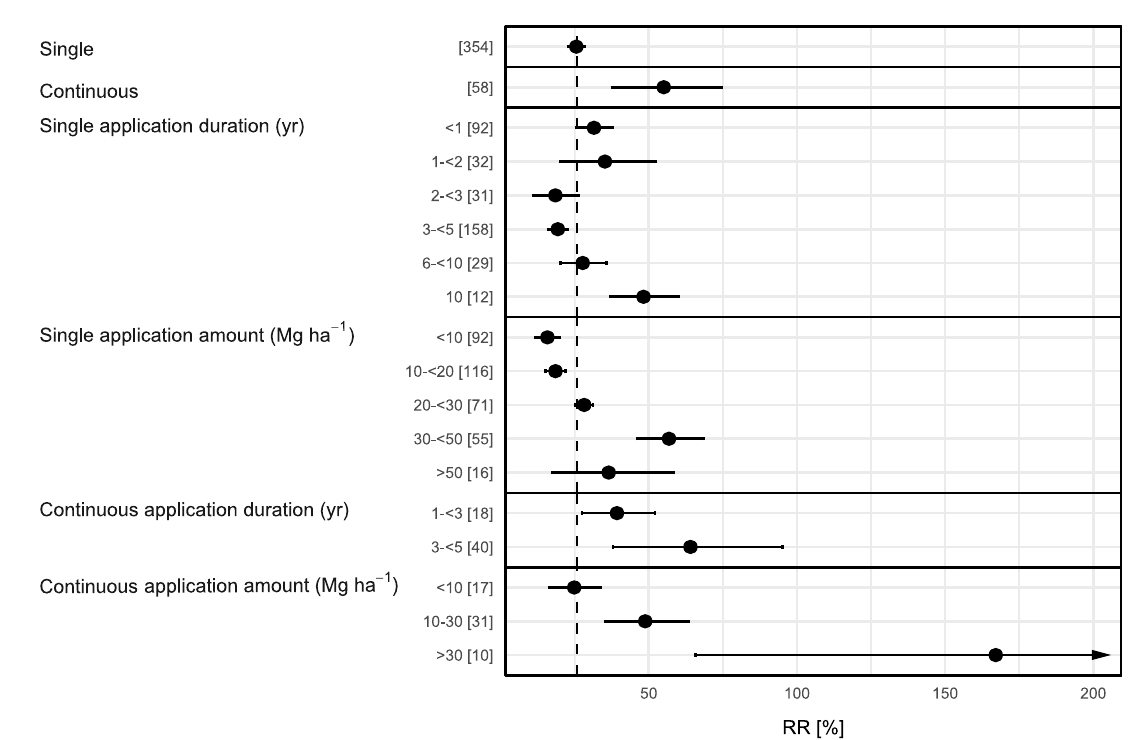
Figure 6. Meta-analysis results of the “field dataset”, given as a forest plot. Presented is the relative response ratio (RR [%]) of soil organic carbon stocks (dSOC) after the application of biochar influenced by whether the application was conducted once (single application) or repeatedly (continuous application). Points within the range represent the mean dSOC and the line within the 95% confidence interval represents the range of the effect size. If the effect size range crosses the “zero-effect-line”, given as a solid vertical line at 0%, the result can be interpreted as statistically insignificant. The effect sizes of each group were considered to be significantly different at p < 0.05 from each other if the 95% confidence intervals were not-overlapping. A vertical black dotted line represents the grand overall